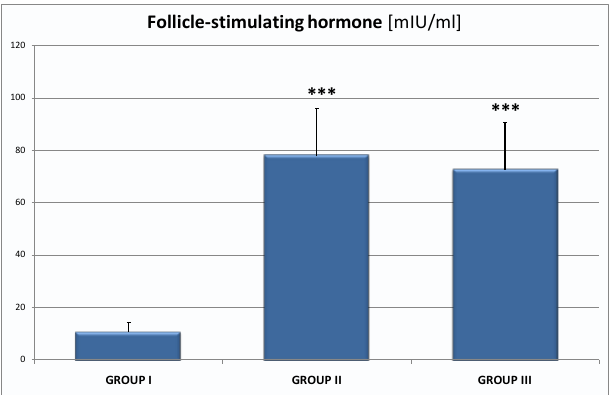
Figure 3. The level of estradiol in group I 49.16 ± 19.80 pg/mL, group II 15.49 ± 6.33 pg/mL, group III 19.01 ± 3.87 pg/mL; they are the significant differences in mean value between group I and II; group I and III; *** p < 0.001.